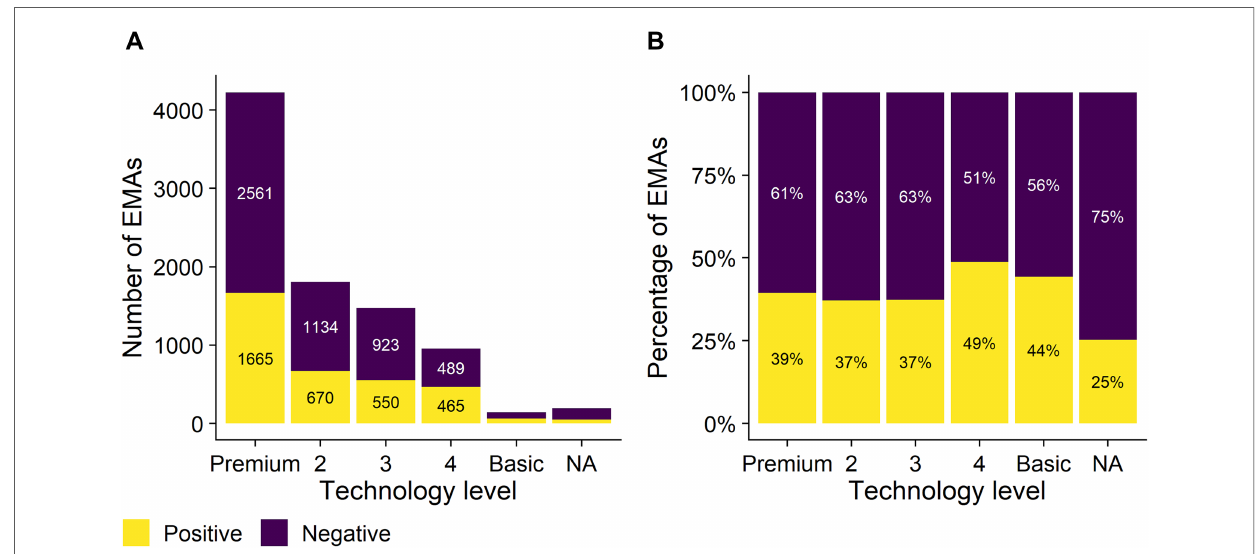
FIGURE 2 Number of self-initiated EMAs ( y -axis; panel A ) and proportion of self-initiated EMAs ( y -axis; panel B – one column adds up to 100%) logged as a function of the technology level of the hearing devices that the smartphone app was connected to ( x -axis). Five different technology levels were considered, ranging from premium (left) to basic hearing aids (right) in descending order. Yellow and purple bars represent positive and negative self-reported satisfaction ratings,